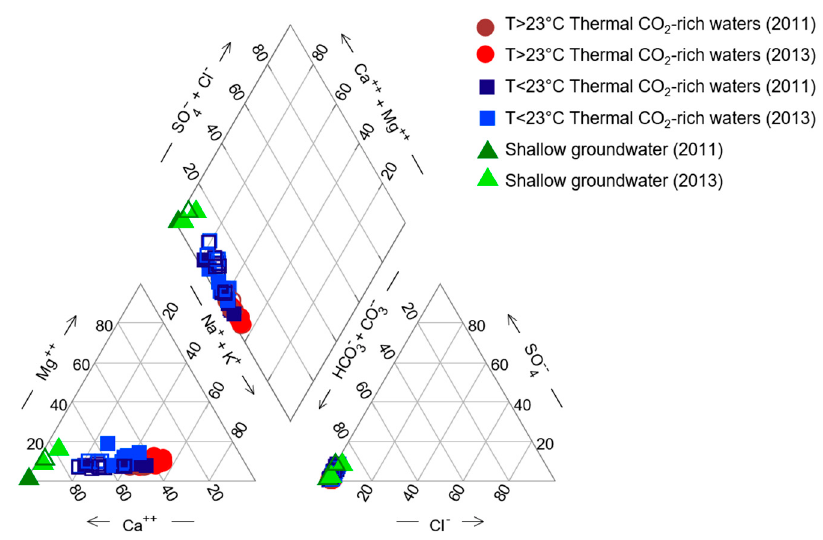
Figure 3. Piper diagram of spring water compositions in the study area (data for 2011 [26], 2013 this study). Open symbols are samples with SO4 > 0.4 meq/L.